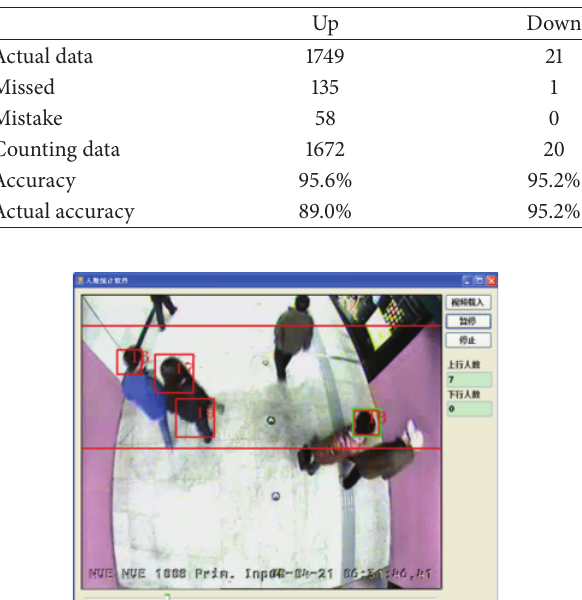
Table 8: Experimental results with threshold-curve.